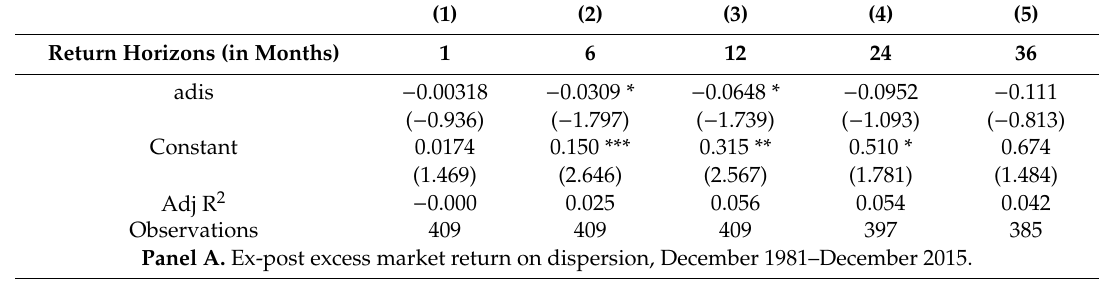
Table 2. Univariate regressions of future excess market returns on aggregate